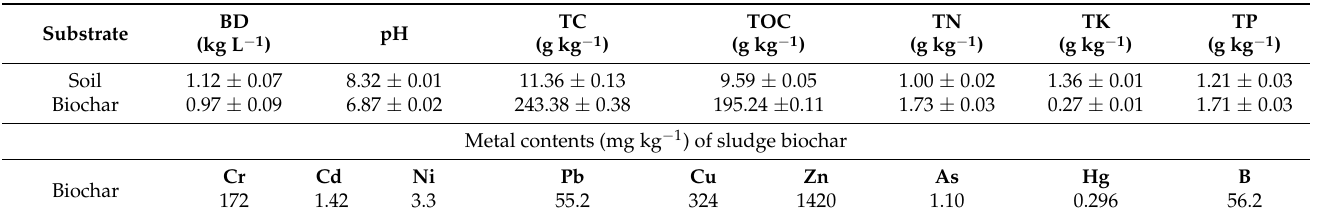
Table 1. Properties of the initial soil and biochar of the green roof before planting.